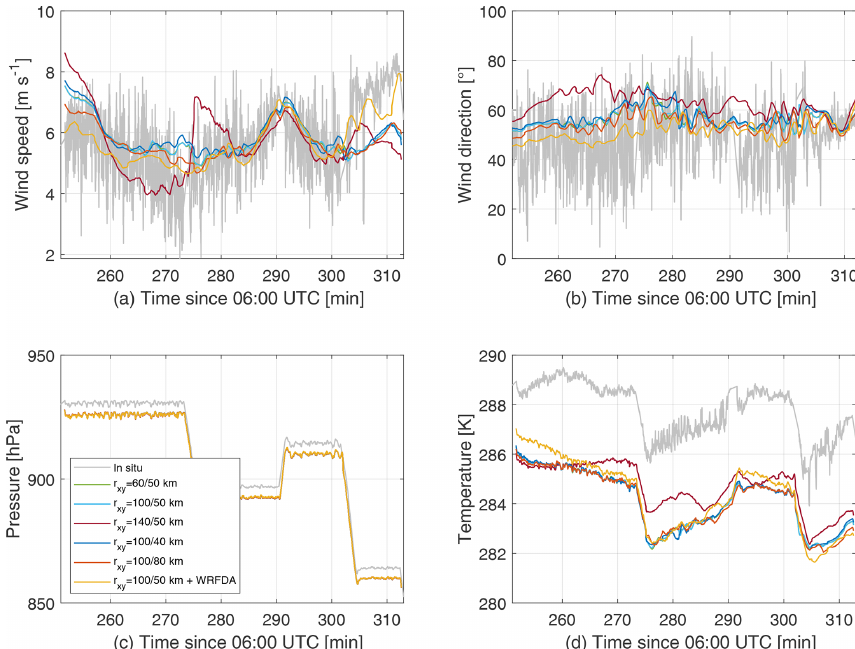
Figure 6. Comparison of 1Hz wind speed (a) , wind direction (b) , static pressure (c) , and static air temperature (d) as measured aboard the Cessna 208B on 6 June 2018 between 10:00 and 11:20UTC to ensemble runs with varying r xy from above. The graphs are plotted as a function of time in minutes since